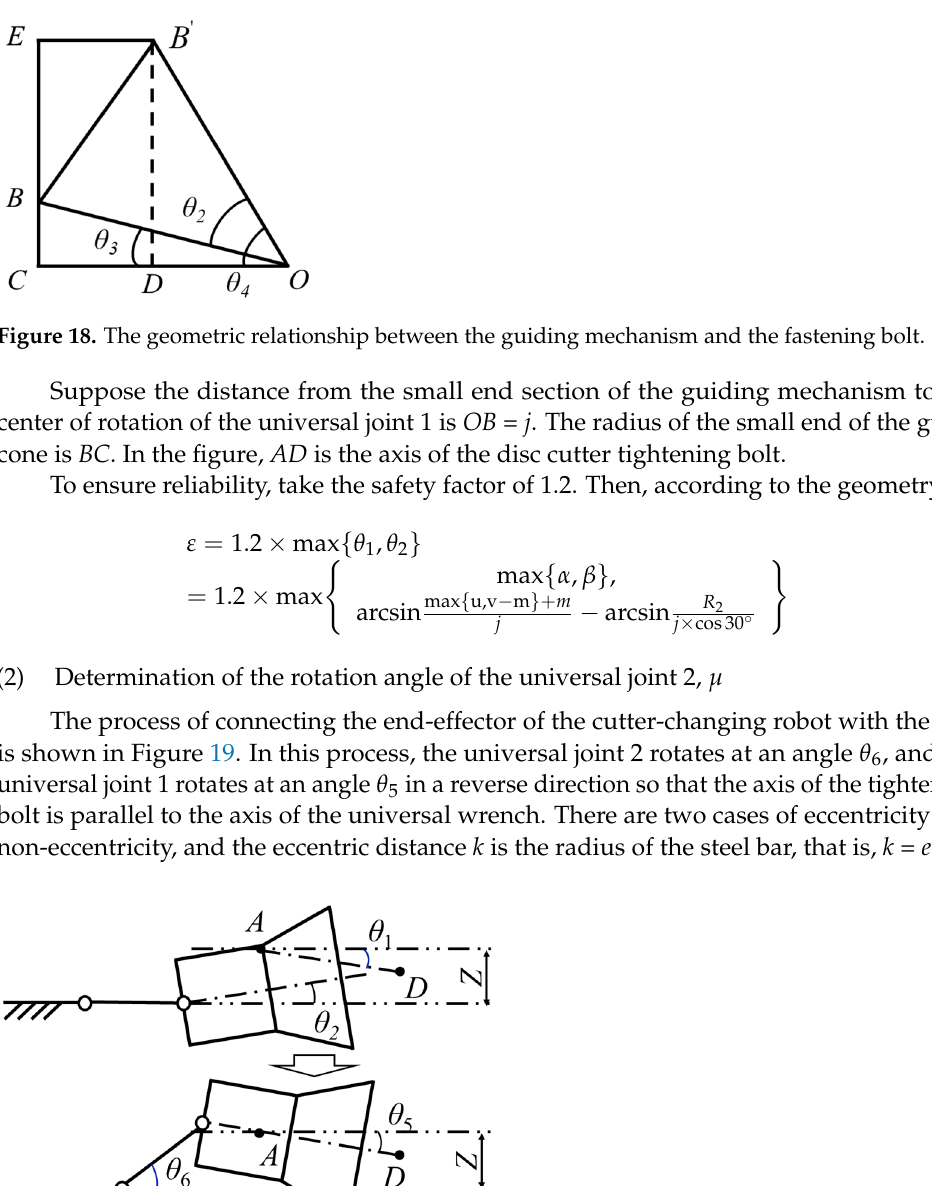
Figure 19. The process of connecting the universal wrench with the bolt.